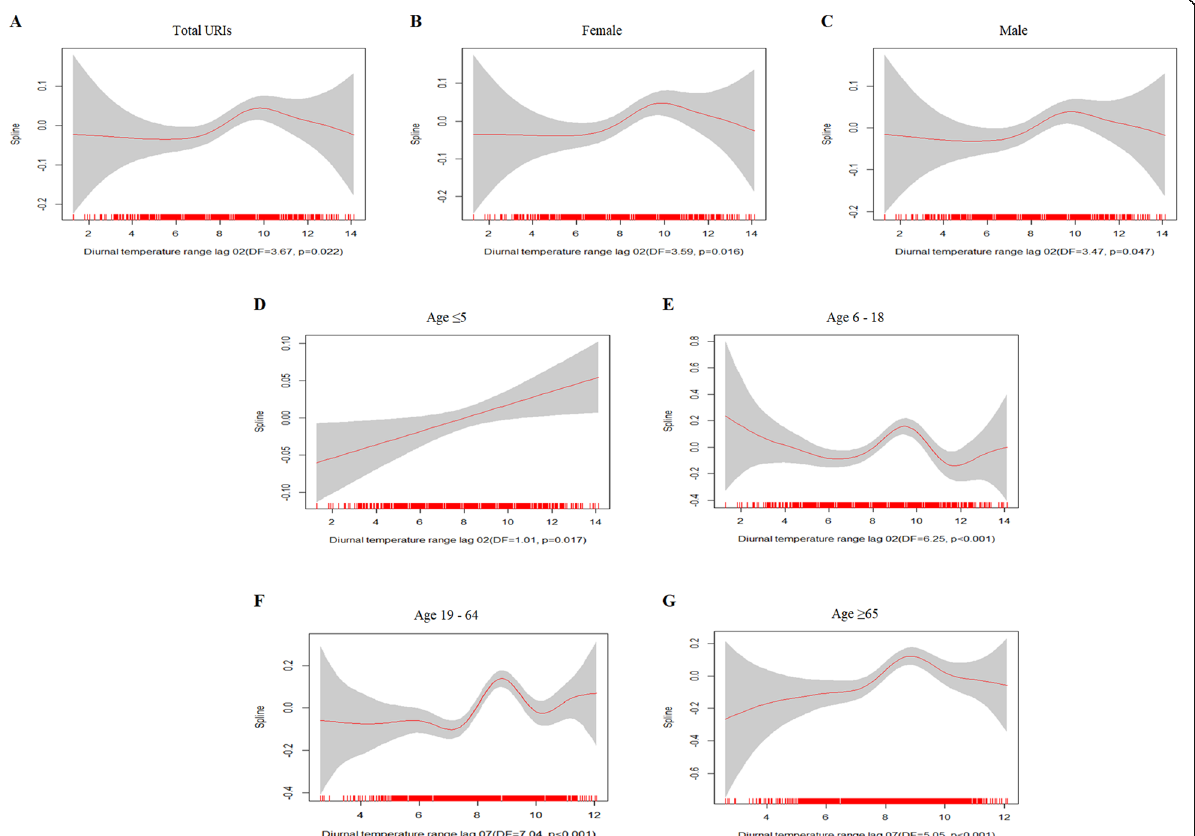
Fig. 2 The smoothed exposure-response curves between diurnal temperature range (DTR) and emergency room (ER) visits for upper respiratory tract infections (URI) in different subgroups in Seoul, Korea, 2009 to 2013. The line represents a spline curve and the shaded area represents the 95% confidence intervals. The models were controlled for the average temperature, relative humidity, particulate matter with a median aerometric diameter < 10 microns (PM 10 ), ozone (O 3 ), time trend, seasonality, day of the week (DOW), and